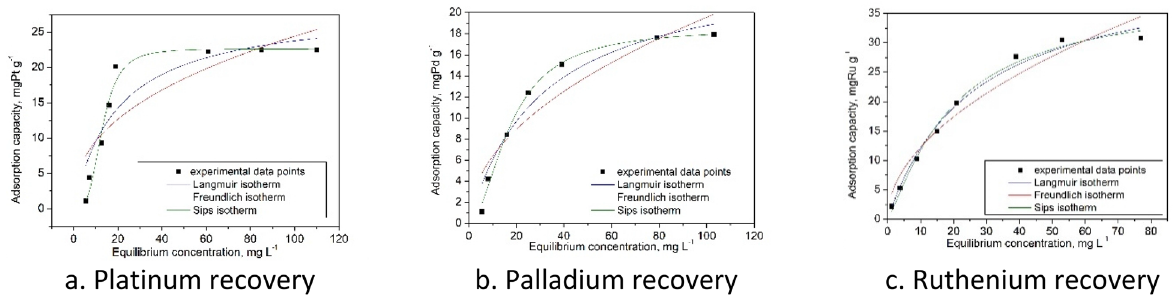
Figure 13. Adsorption isotherms.